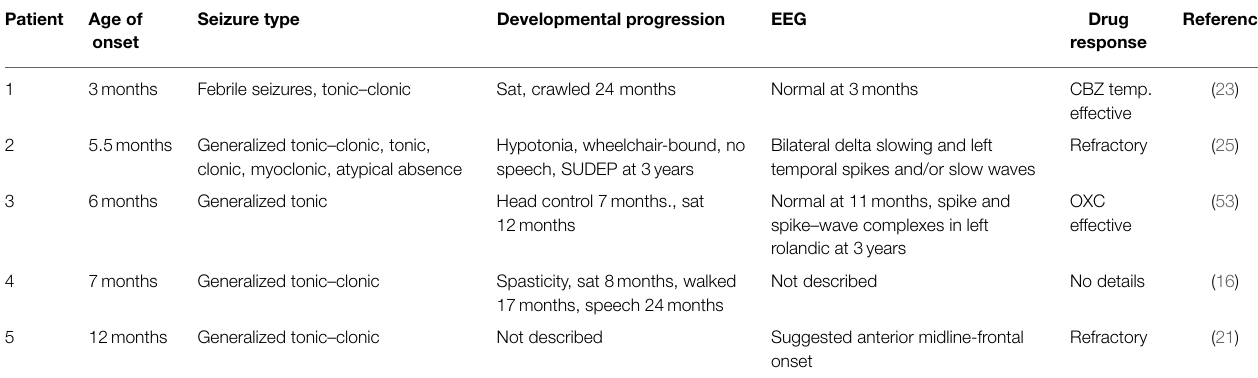
TABLE 2 | Phenotypic variability in patients with the p.Arg1617Gln mutation in SCN8A.